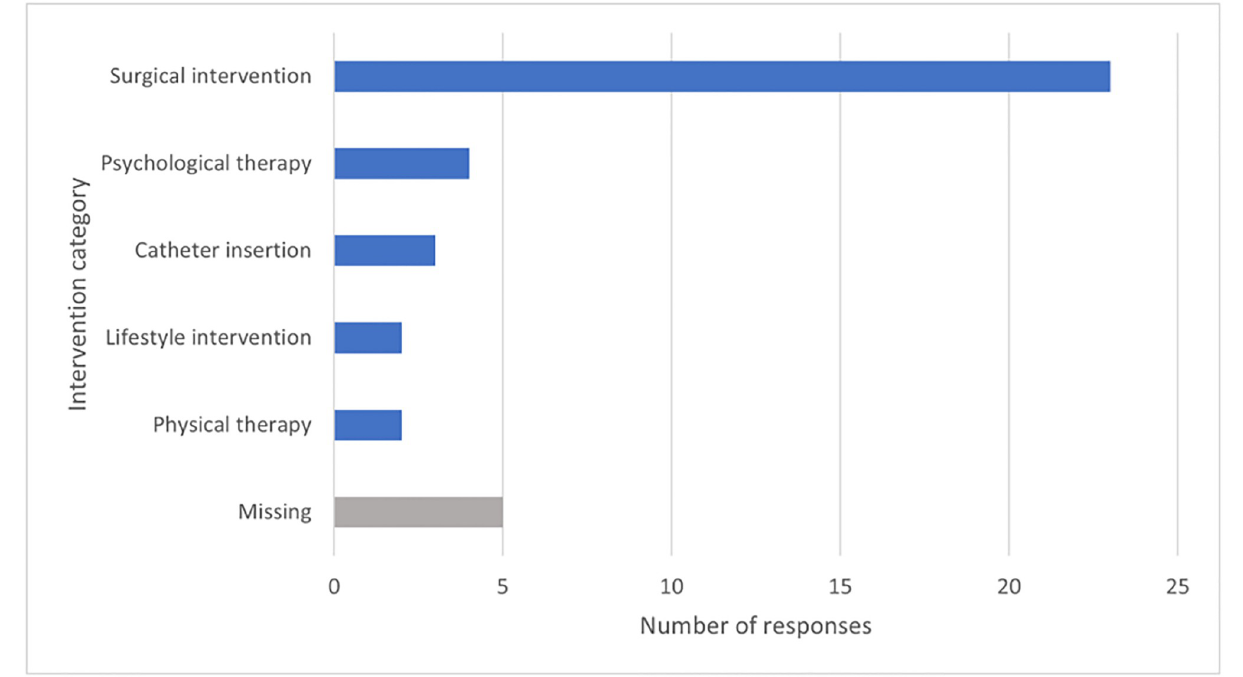
Fig 1. Summary of survey responses relating to intervention category (n = 39).